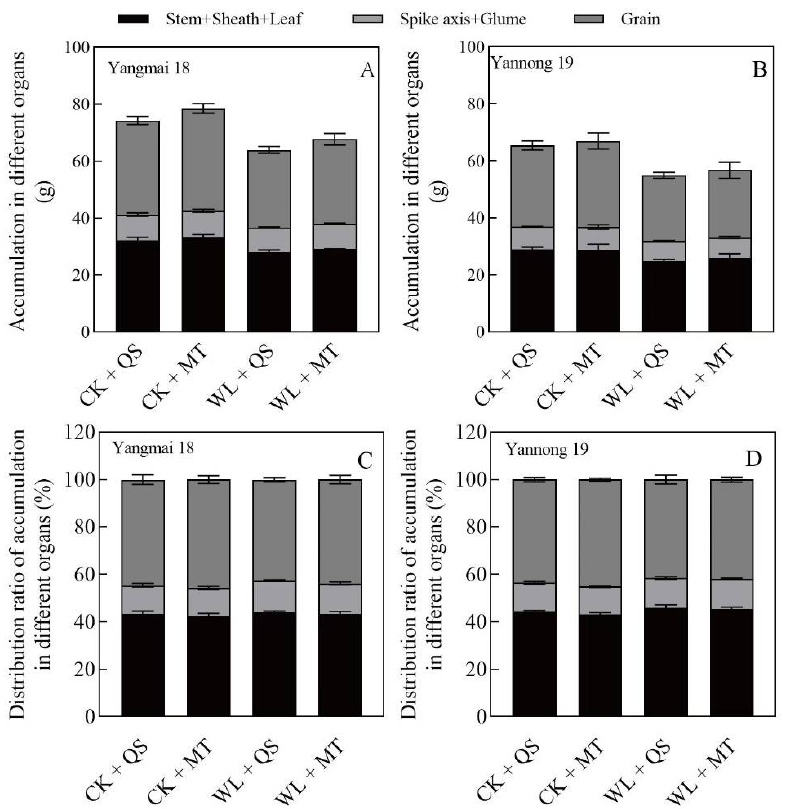
Figure 10. Dry matter accumulation and distribution of Yangmai 18 ( A , C ) and Yannong 19 ( B , D ) under different treatments, i.e., CK + QS: leaf spraying with distilled water under non-waterlogged conditions; CK + MT: leaf spraying with 100 µ mol · L − 1 of melatonin under non-waterlogged conditions; WL + QS: leaf spraying with distilled water under waterlogged conditions; WL + MT: leaf spraying with 100 µ mol · L − 1 of melatonin under waterlogged conditions.